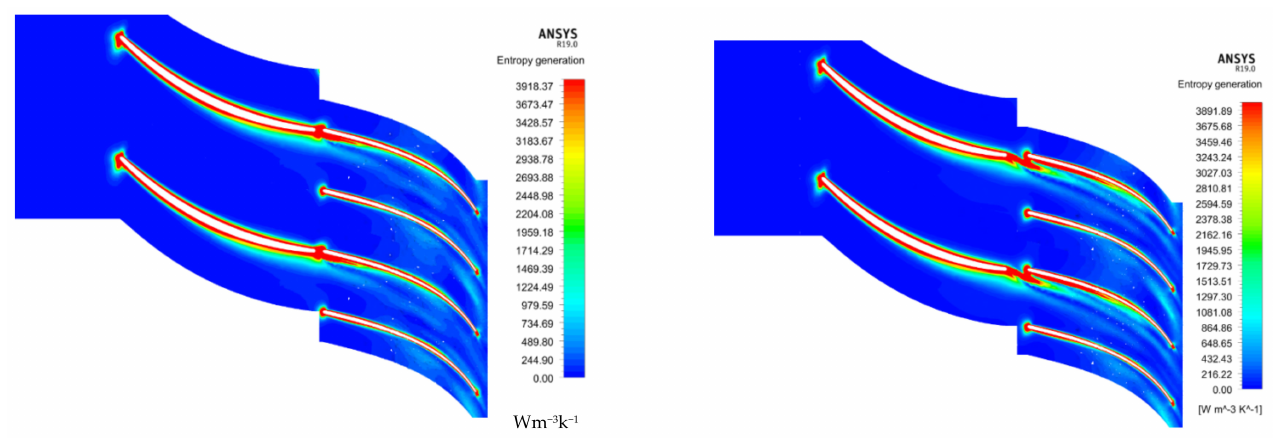
Figure 20. Relative velocity maps for 0% clock, clearance 0.5 mm ( left ) and 1.5 mm ( right ). m r =